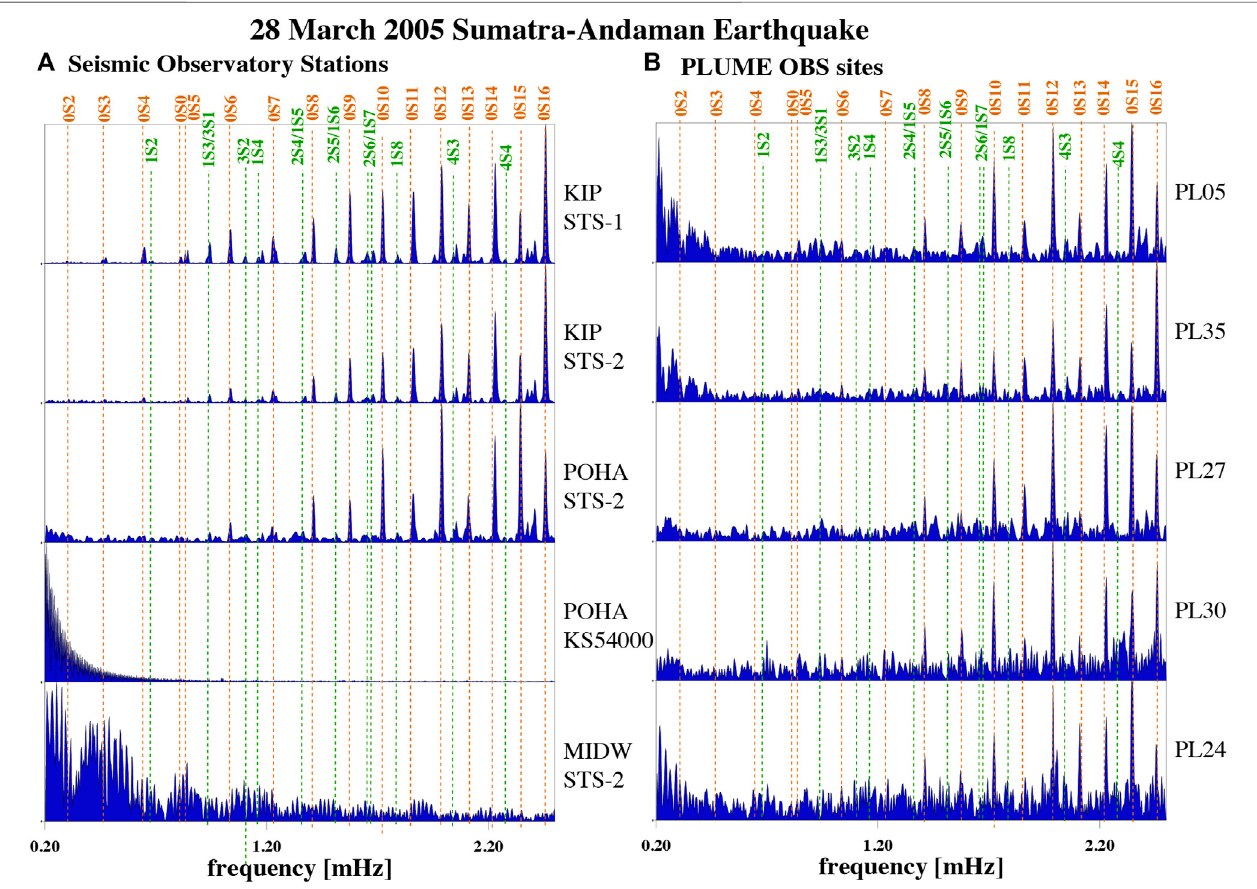
FIGURE 4 | Normalized raw vertical-component spectra for the March 28, 2005 Sumatra-Andaman earthquake of 50-hourlong segments, starting 1.5 h after the event time. (A) Spectra at stations of permanent observatory stations KIP, POHA and MIDW. The sensor type is listed below the stations name. Stations KIP and POHA featured two sensors, where the secondary sensor (location code 10) was a STS-2 broadband sensor. (B) Spectra at fi ve OBS sites with the best signal-to-noise ratio. The sensor was a Güralp CMG-3T sensor. See Supplementary Table S1 in the supplement for earthquake parameters.